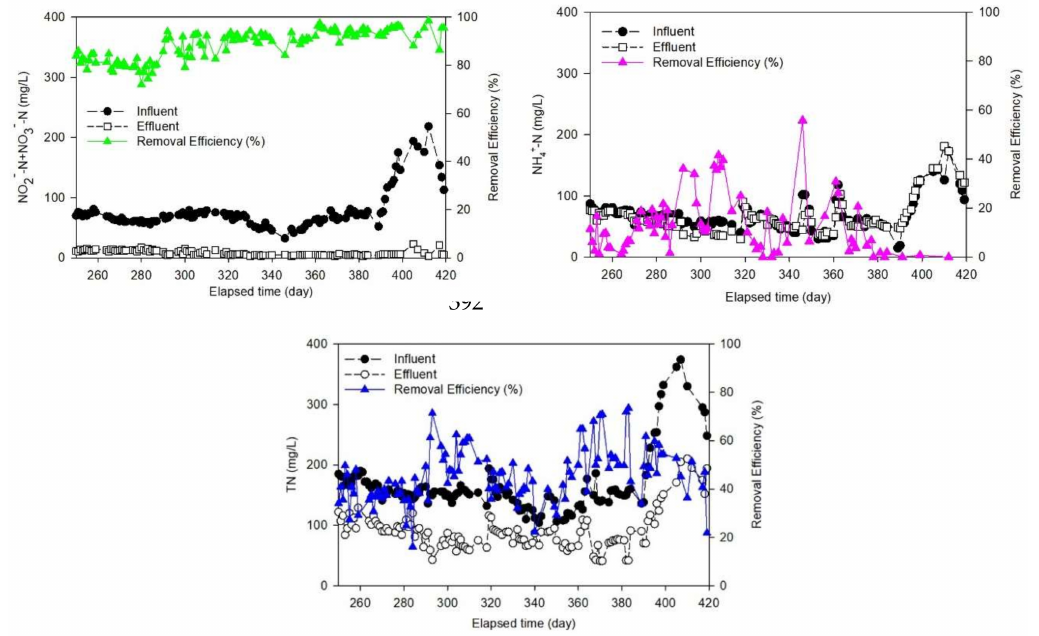
Figure 5. Treatment performance of the SOD process during long-term operation: Variations of TN, NH4+-N, NO2–N, and NO3–N concentrations and removal